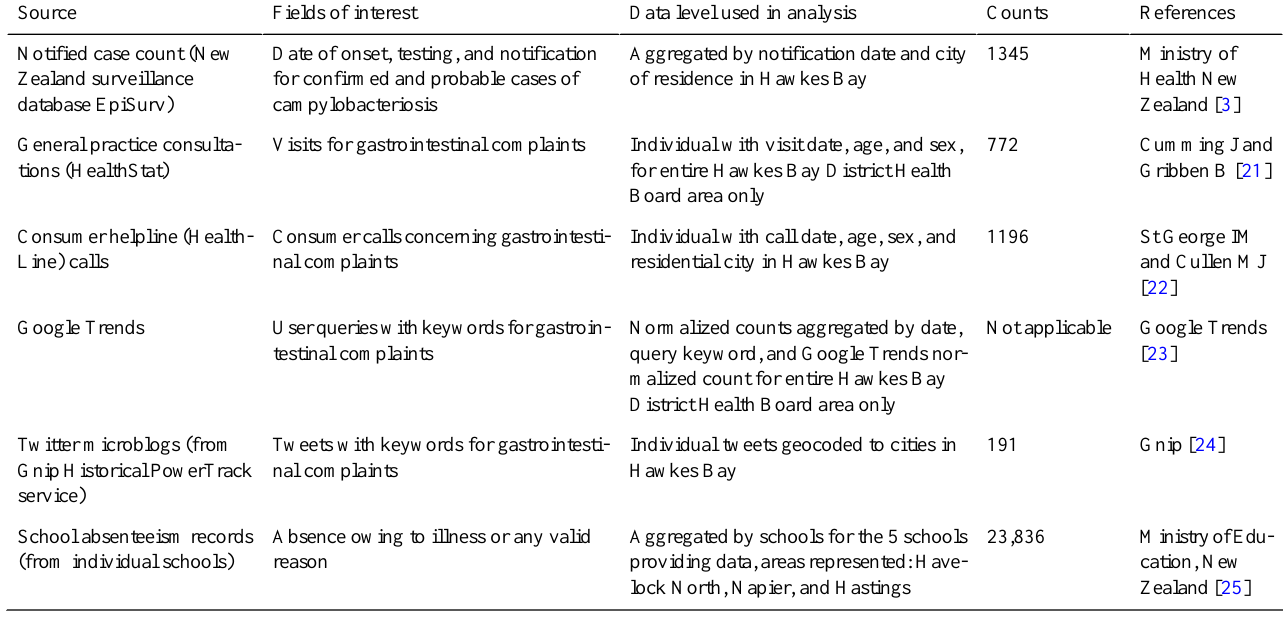
Table 1. Description of data sources used in